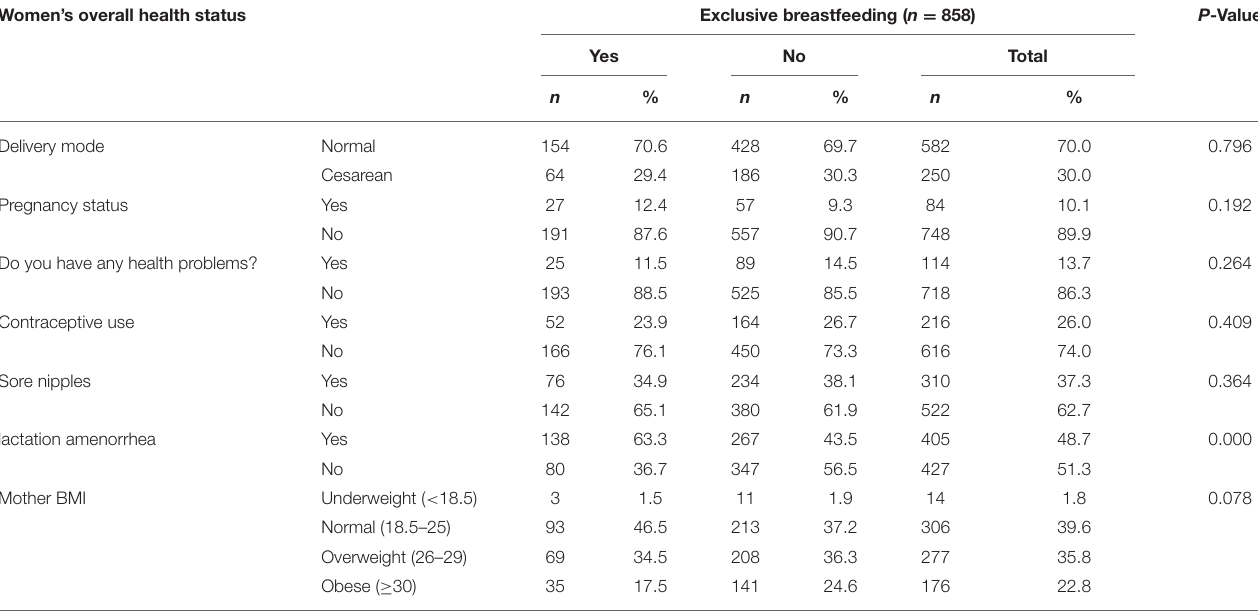
TABLE 4 | Association between EBF and women’s obstetric and general health status variables. Women’s overall health status